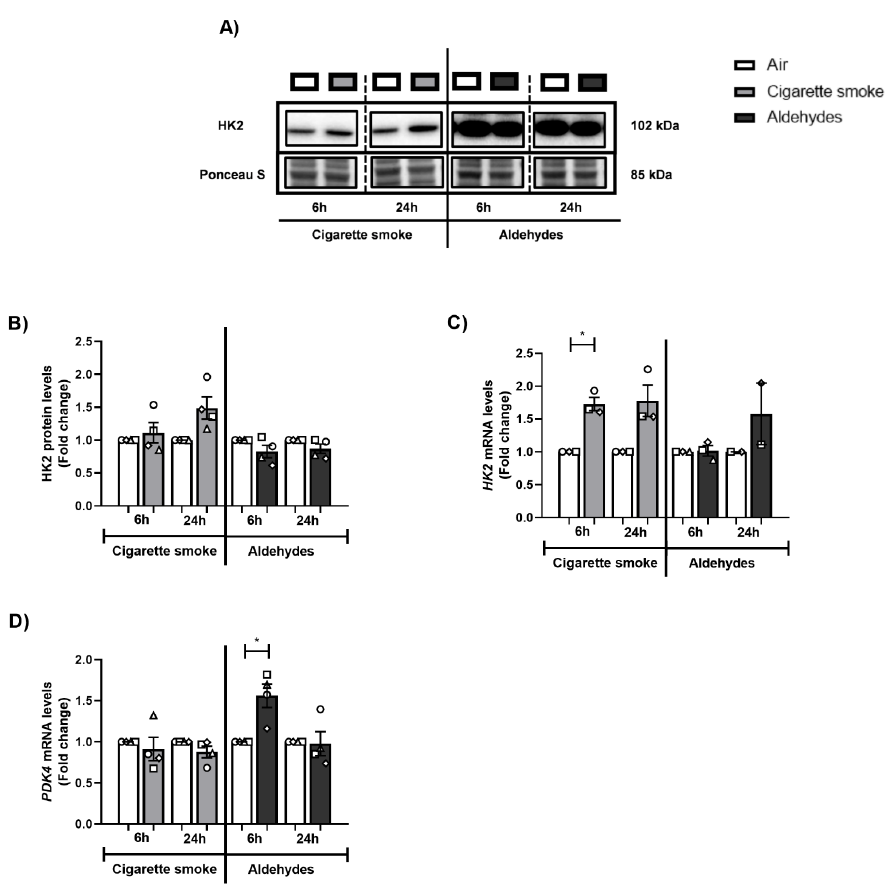
Figure 8. Increased abundance of genes associated with glucose metabolism upon CS or aldehyde exposure. Differentiated human primary bronchial epithelial cells (PBEC) from non-COPD subjects ( n = 2 – 4 donors) were exposed to smoke of one Marlboro Red cigarette (CS), or a mixture of acetaldehyde, acrolein, and formaldehyde (at concentrations equivalent to one cigarette), or air (control), under a continuous flow system using a puff-like exposure protocol. After recovery for 6h or 24h, whole cell lysates were harvested to analyze ( A , B ) protein levels of HK2. Representative Western blot images are shown for one replicate from one donor per experiment, reflective of the changes in all donors as quantified in the corresponding graph. Transcript levels of ( C ) HK2 and ( D ) PDK4 were analyzed. Data are presented as mean fold change compared to air control ± s.e.m. The mean values of biological triplicates for each independent donor are represented by open circles, triangles, squares, or diamonds. Statistical differences between CS vs. air and the mixture of aldehydes vs. air were tested using a two-tailed paired parametric t -test. Statistical significance is indicated as * p < 0.05 vs. air (control).